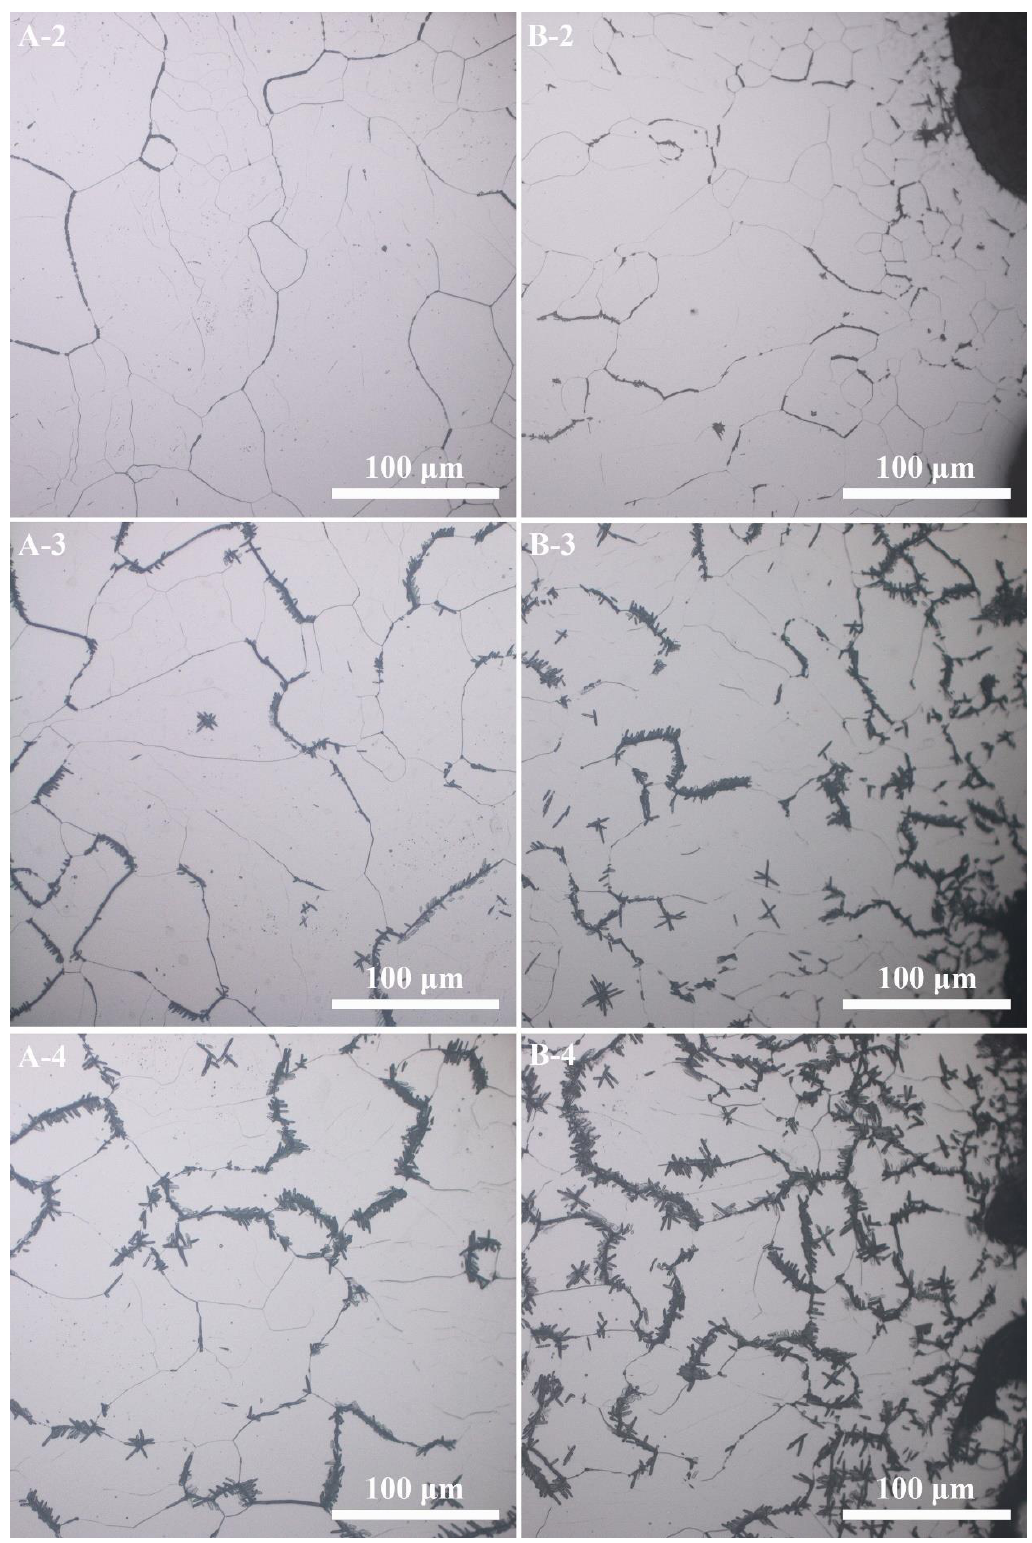
Figure 11. Optical image of the cross-section in different segments of the sample. (The pictures with the letter (“ A ”) represents the central area of the cross-section, and the pictures with the letter (“ B ”) represents the cross-section of sample near its side surface. Number 2–4 on the pictures represents segment 2–4 as illustrated in Figure 2b.).